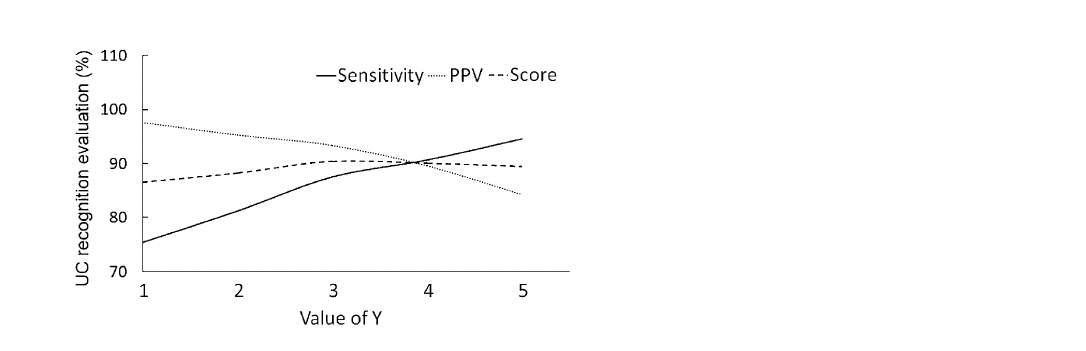
Figure 2. The influence of γ on the recognition